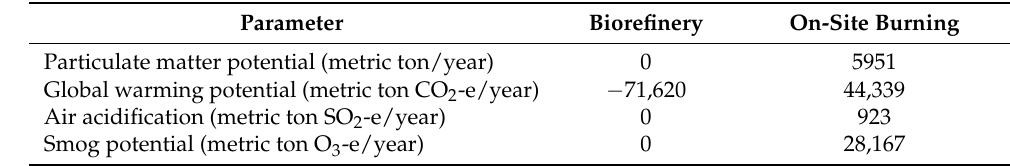
Table 7. Comparison of the life cycle impact assessment between the biorefinery (50,000 metric tons ethanol/year) and control on-site